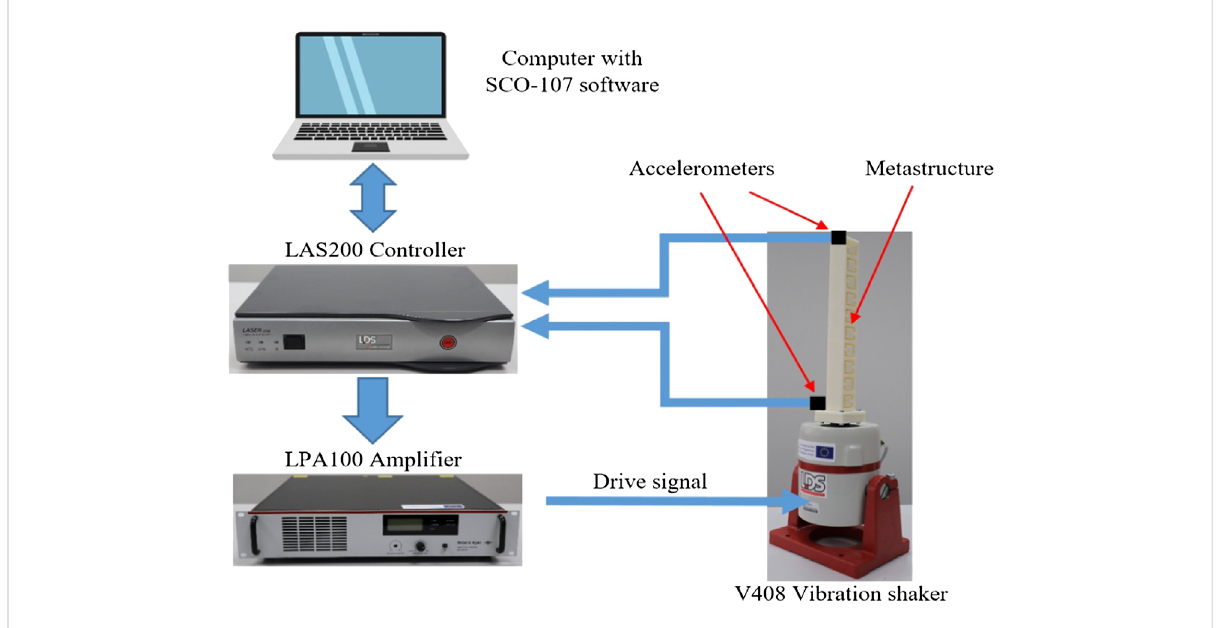
FIGURE 6 Experimental setup.